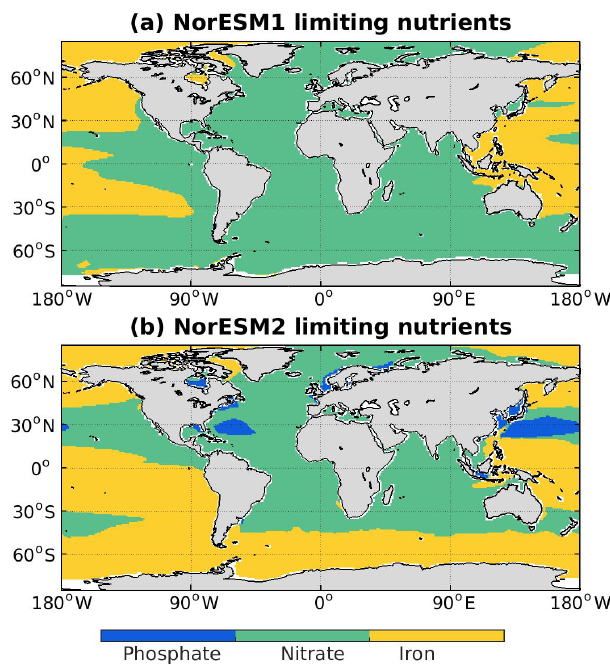
Figure 10. Maps of limiting nutrients for biological productivity as simulated in (a) NorESM1 and (b) NorESM2. The limiting nutrient is determined as the minimum between PO 4 , R P : N · NO 3 , and R P : Fe ·